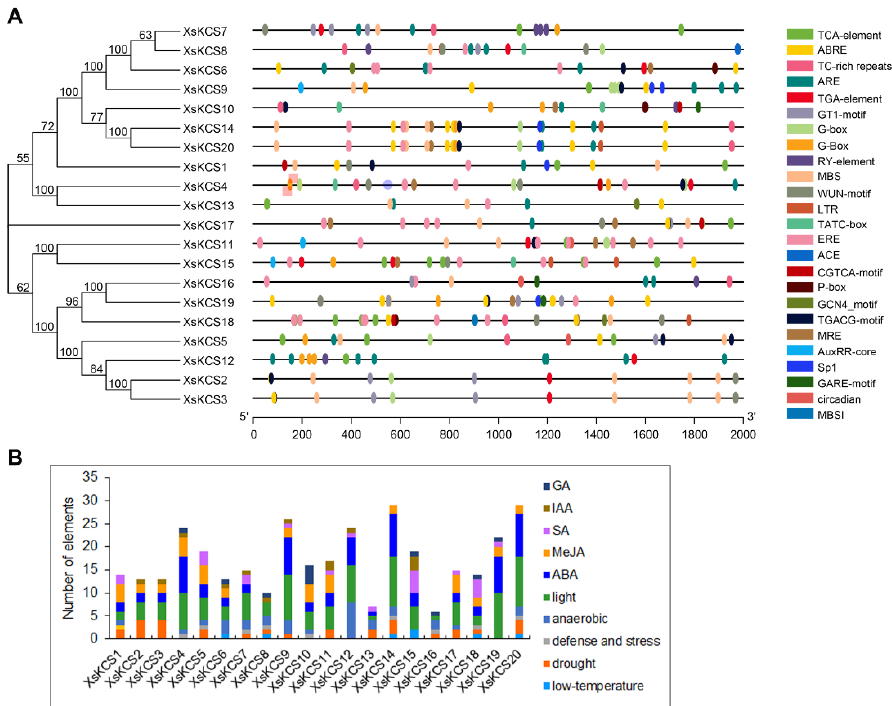
Figure 5. Distribution of cis-acting regulatory elements of the XsKCS genes in yellow horn. ( A ) The cis-acting regulatory elements identified in 20 XsKCS genes. The different colored boxes represent different cis-acting regulatory elements. ( B ) The bar graphs of the numbers of different cis-elements. The similar cis-elements are exhibited with the same colors.